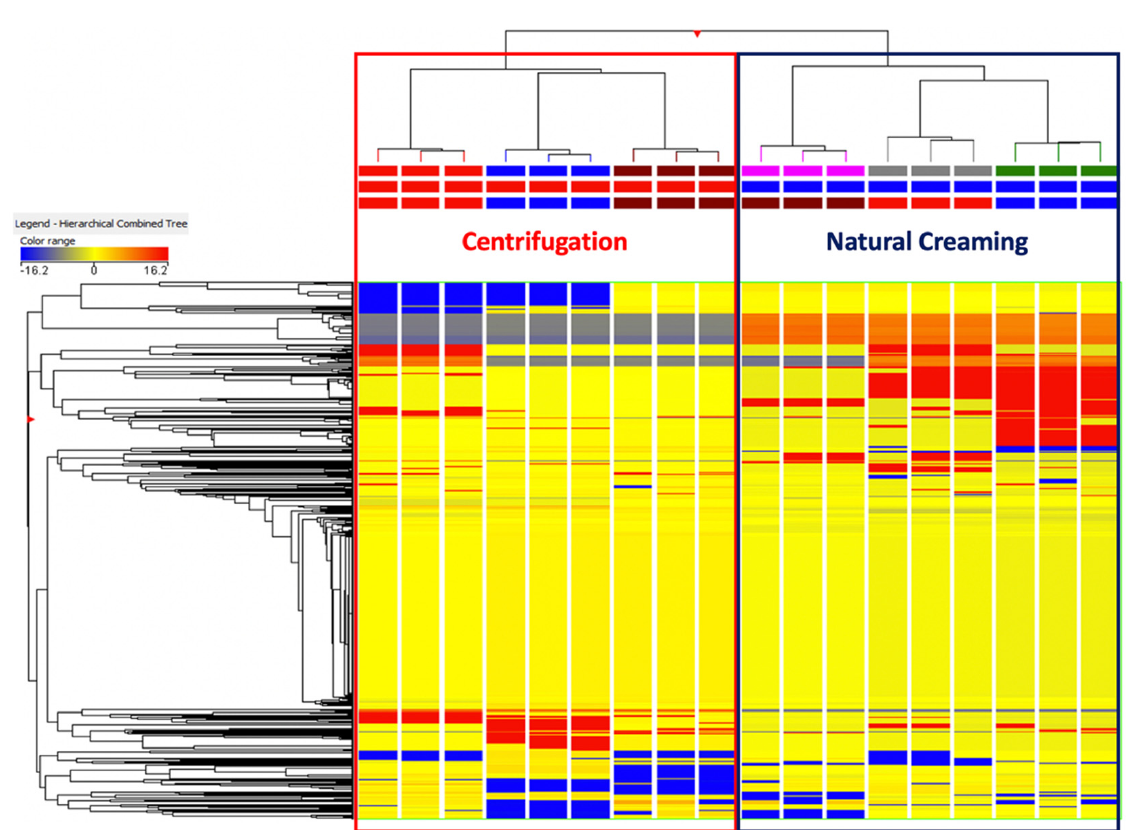
Figure 1. Unsupervised hierarchical cluster analysis (HCA) based on fold-change heat map (similarity: Euclidean; linkage rule: Ward) for the different milk creams resulting from centrifugation and natural